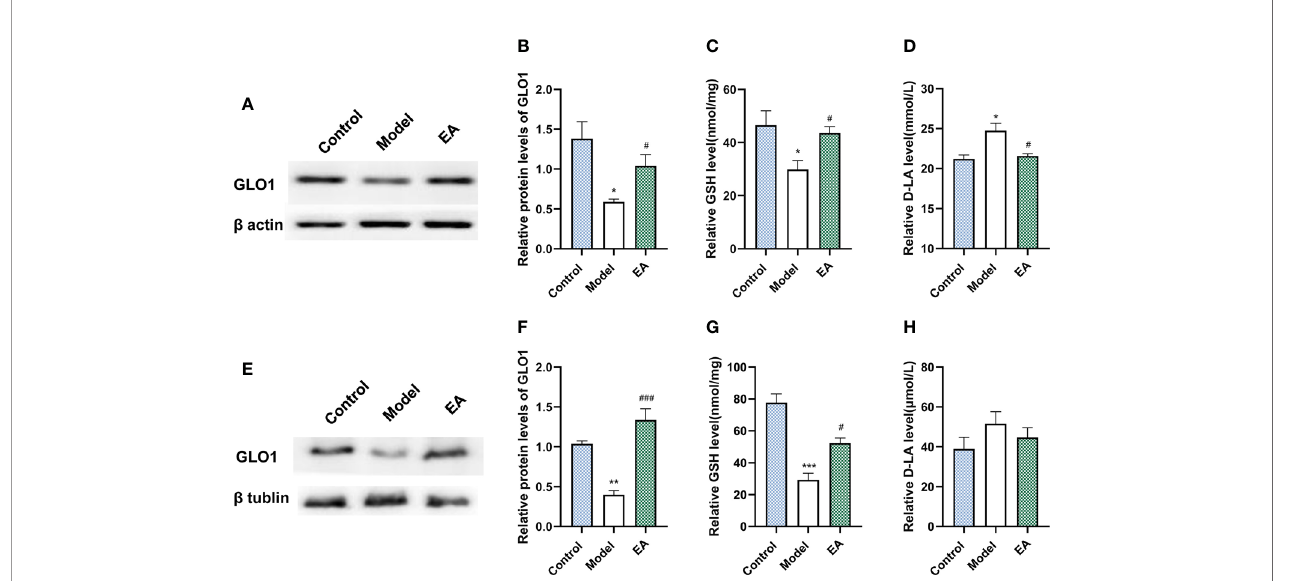
FIGURE 6 | Effect of EA on the expression of GLO1, GSH, and D-lactate in footpad skin and sciatic nerve. (A) Representative Western blot analysis of GLO1 staining and (B) relative protein levels in footpad skin (n=3, *p < 0.05, # p < 0.05). (C) Representative ELISA analysis of GSH and (D) D-lactate in footpad skin (n=4,